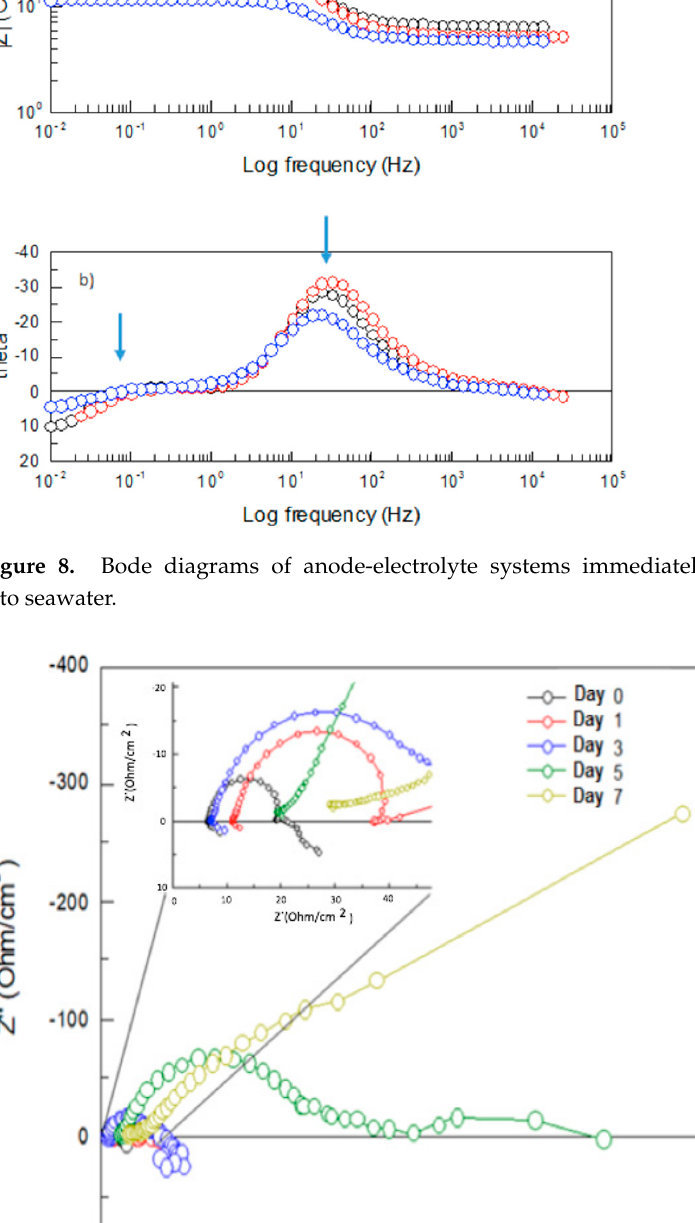
Figure 10. Nyquist diagrams for Mg ‐ 1Cr anode for 0, 1, 3, 5, and 7 days of immersion in seawater.